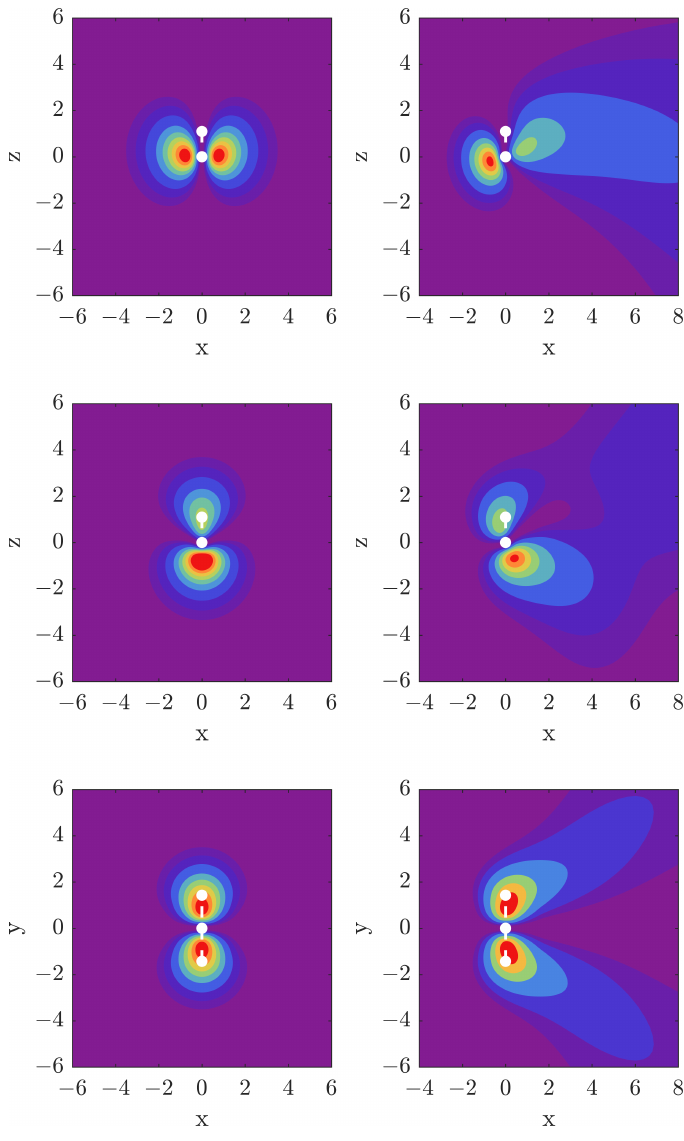
Figure 1. Probability densities of the MOs calculated at the level of (cid:96) max = 3 with an x -directed force: 1 b 1 ( top row ), 3 a 1 ( middle row ), and 1 b 2 ( bottom row ). On the left are the field-free cases, and on the right with electric force applied with strengths 0.12, 0.20, 0.28 a.u., respectively, which give similar decay rates. Contour heights starting with the outermost are 0.005, 0.01, 0.02, then they increase in steps of 0.02 a.u. The positions of the nuclei are marked by white